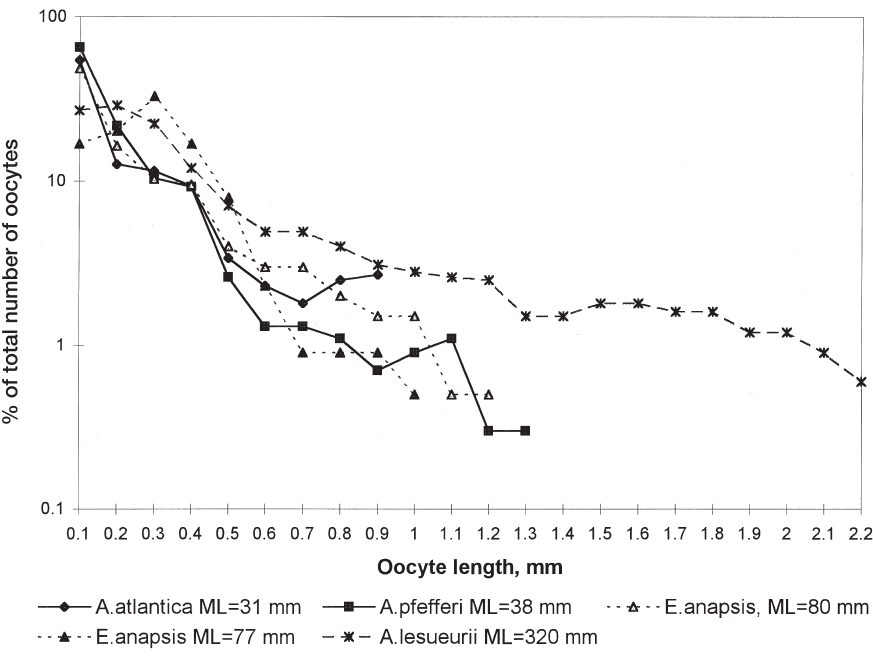
Fig. 2. – Size distribution of oocytes in mature